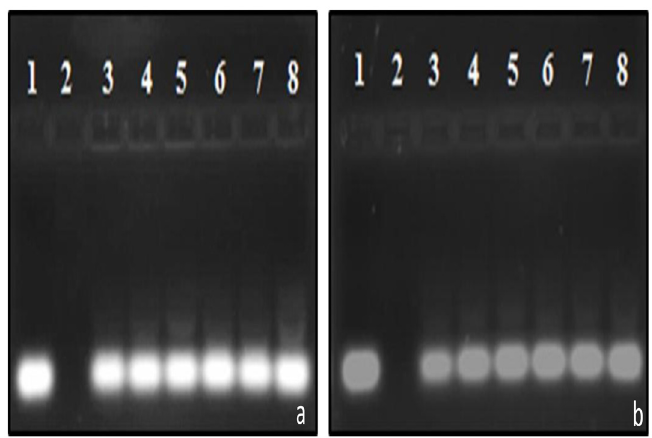
) ratios, as determined by densitometry following gel retardation w ) ratio at which maximum siRNA was w